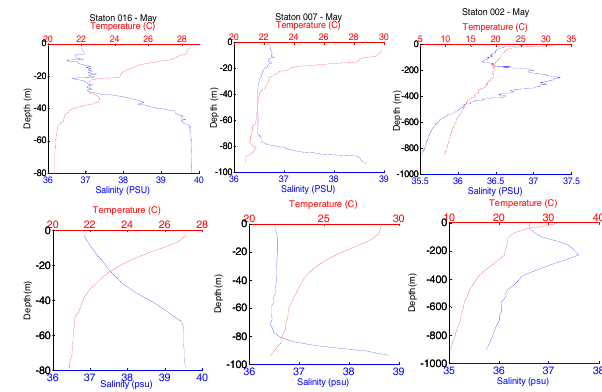
Fig. 7. Typical salinity- temperature profiles during May from CTD measurements (top) and model simualtions (bottom). Locations are shown in Fig.